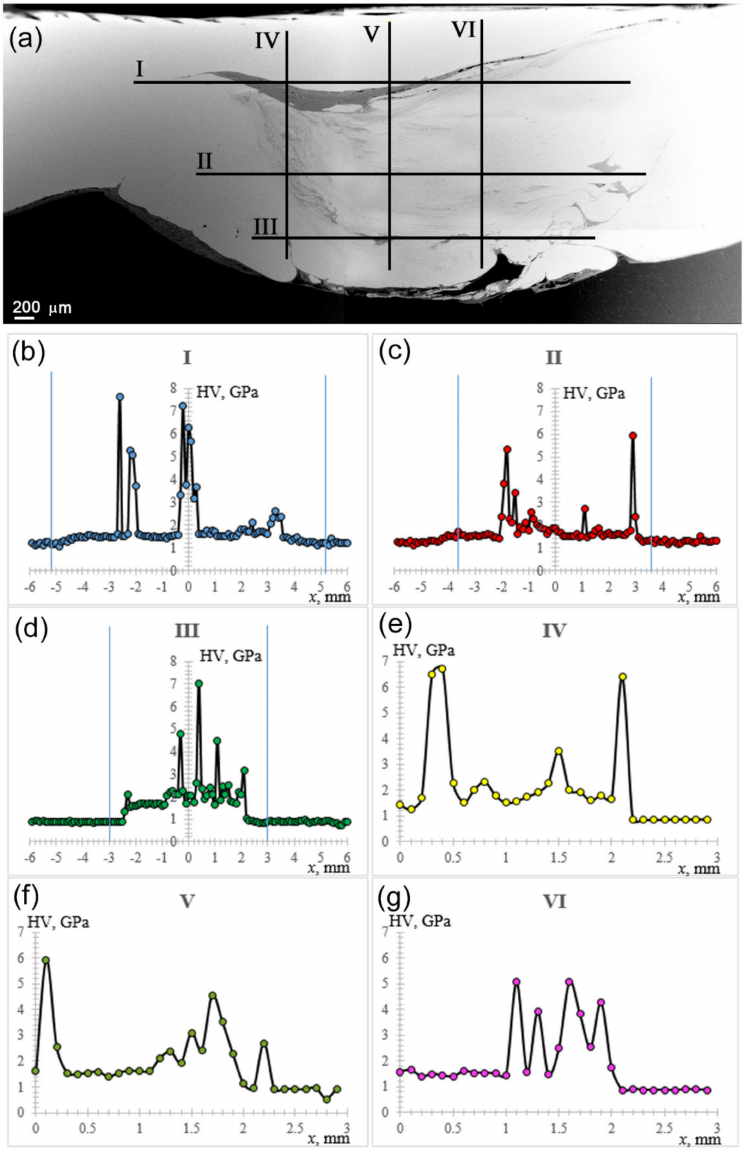
Figure 14. SEM BSE image of the SZ with microhardness measurement lines ( a ), and microhardness profiles obtained along the lines in Figure 14a ( b – g